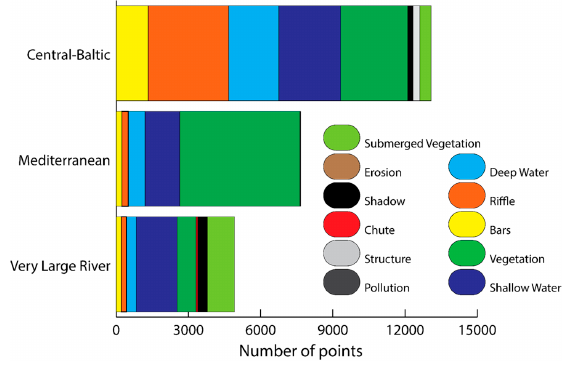
Figure 5. Number of points of the 2 m × 2 m ground truth grid allocated to each feature for each of the Geographical Intercalibration Groups (GIGs). Table 6. Summary of the ANN performance in hydromorphological feature identification per Geographical Intercalibration Group (GIG) and feature. TPR , TNR , FPR and FNR stand for true positive ratio, true negative ratio, false positive ratio and false negative ratio, respectively.